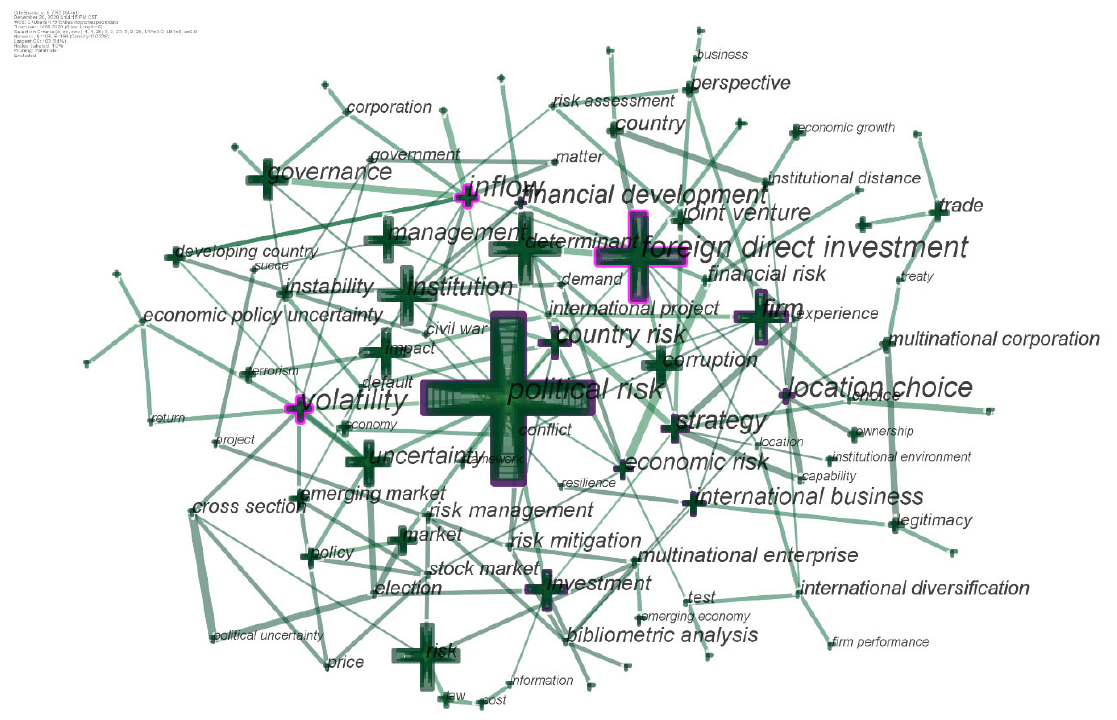
Fig. 9. Keyword map of political risk related papers in WoS